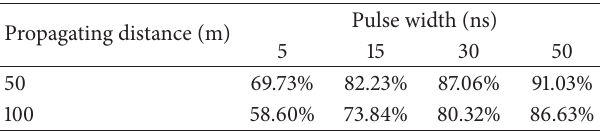
Table 2: Transmittance of peak energy for different pulse